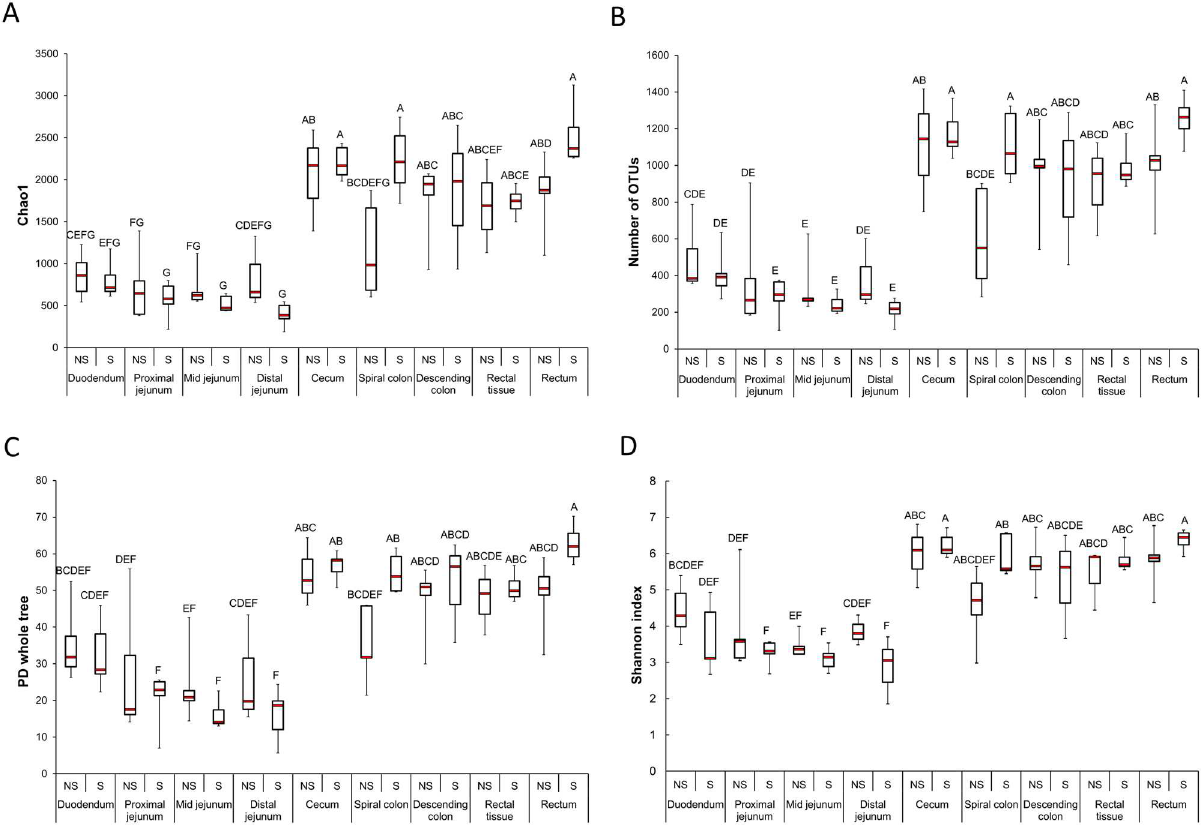
Fig 1. Box plots displaying the bacterial diversity and richness for E . coli O157:H7 shedder (S) and non-shedder (NS) cattle at each gastrointestinal section (n = 10). A) Chao1, B) numberof OTUs, C) PD whole tree, and D) Shannonindex (median ± interquartile